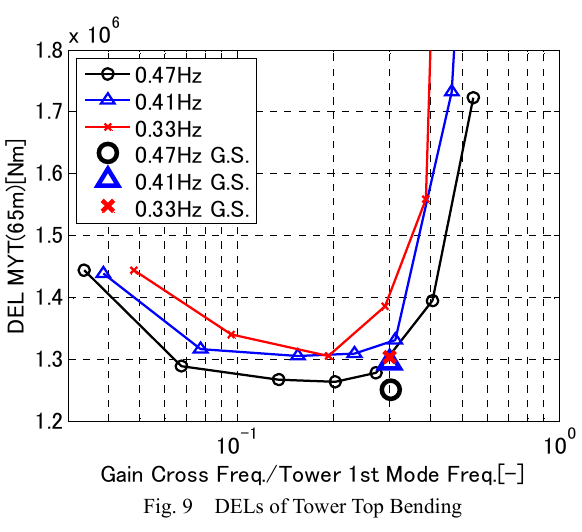
Fig. 9 DELs of Tower Top Bending